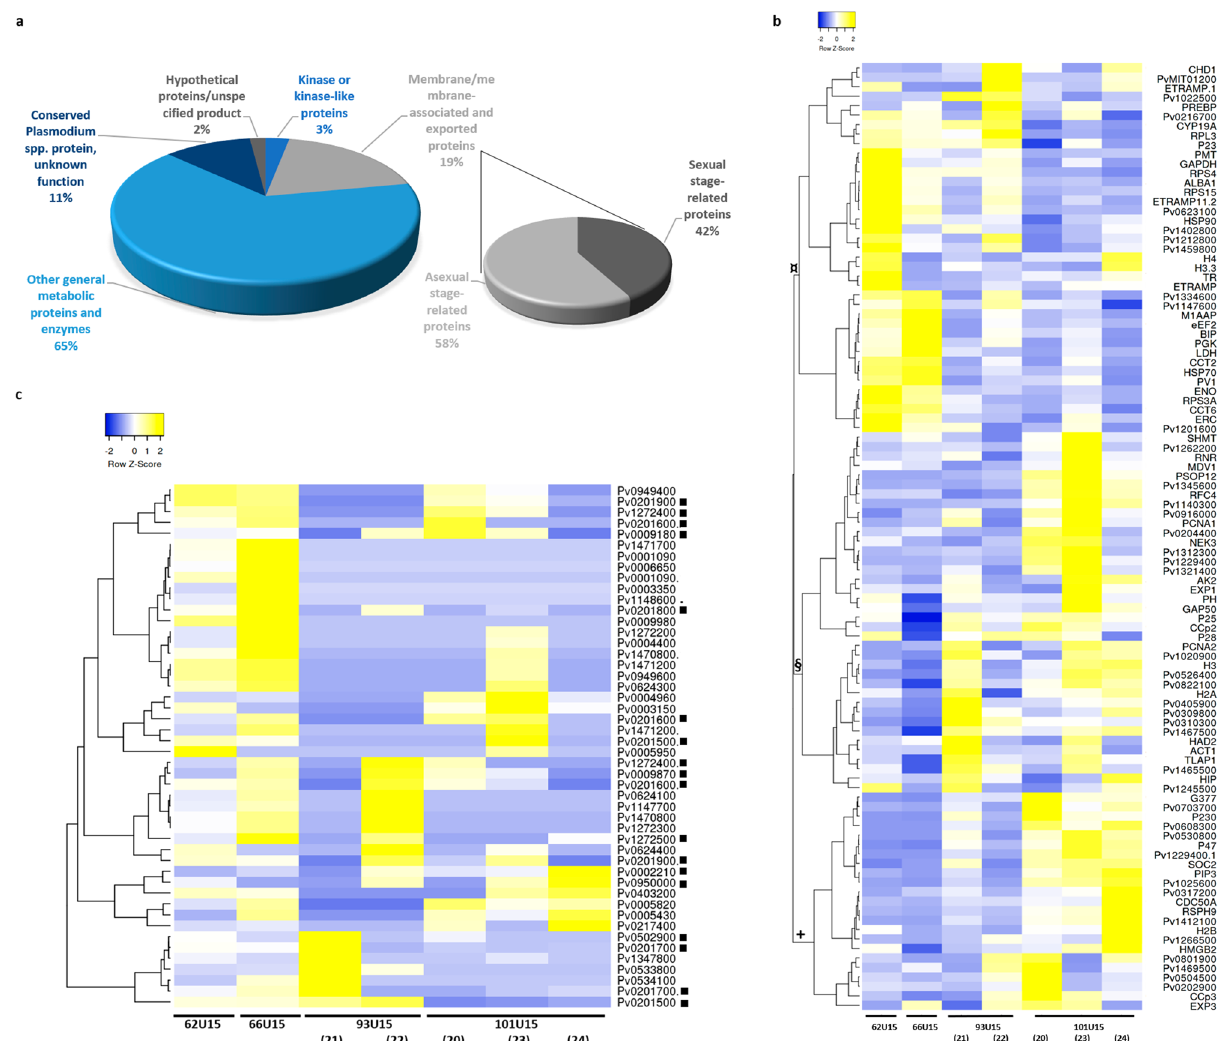
Figure 3. Most expressed P. vivax genes. ( a ) Pie charts showing the top 100 most expressed genes from RNA sequencing of P. vivax field isolates, grouped by general Plasmodium spp . metabolic proteins and enzymes (65%, light blue), membrane, membrane-associated and exported proteins (19%, light grey), conserved Plasmodium- like proteins of unknown function (11%, dark blue), kinases or kinase-like proteins (3%, blue) and hypothetical/ unspecified product proteins (2%, grey). The amplified right-hand side pie chart shows the percentage of asexual (58%, light grey) and asexual (42%, dark grey) membrane, membrane-associated and exported proteins (19%, light grey). ( b ) Heatmap clustering of top 100 most expressed P. vivax exons from the RNA sequenced filed isolates using complete linkage hierarchical clustering method and Pearson’s distance measurement method for computing distance between rows and columns 75 . The three main branches are indicated by symbols + , § and ¤. ( c ) Heatmap clustering of top 48 most expressed transcripts of P. vivax PIR genes from the RNA sequenced filed isolates, using complete linkage hierarchical clustering method and Pearson’s distance measurement method for computing distance between rows and columns 75 . Twenty-one PIR genes are expressed in all isolates (black